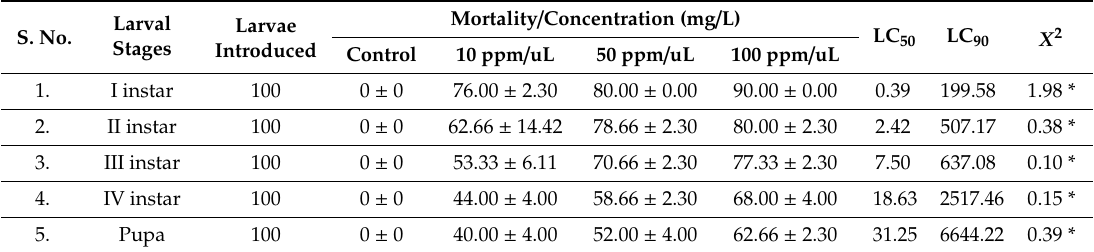
Table 2. Effect of selenium nanoparticles on developmental stages of C. quinquefasciatus at 48 h exposure. S. No.